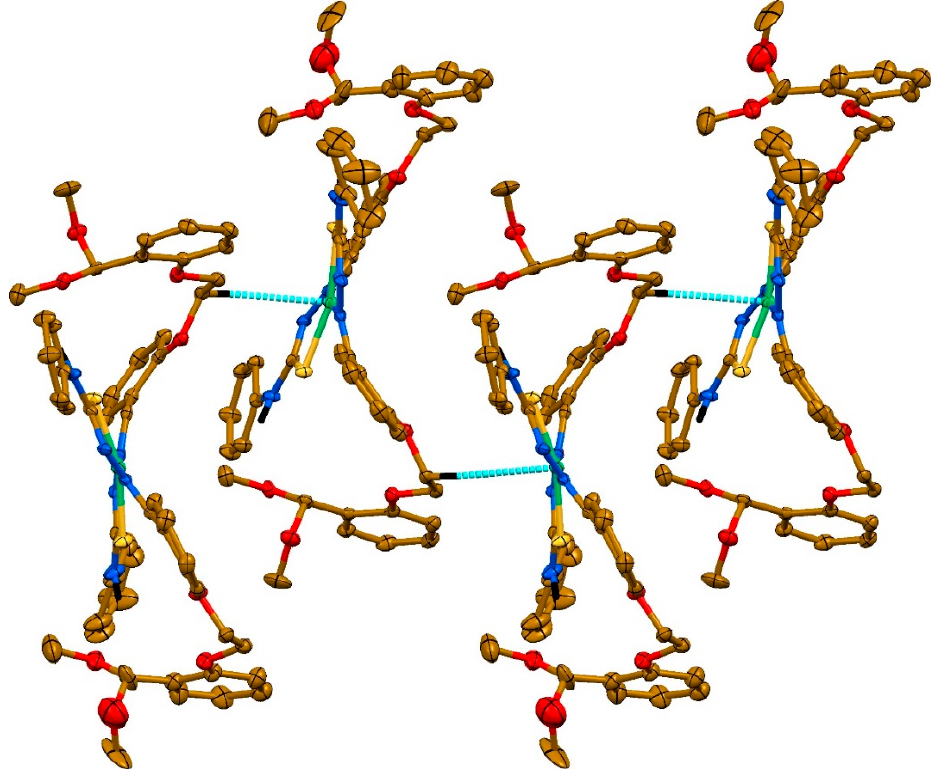
Figure 6. 1D polymeric chain, formed along the b axis by the C–H ∙∙∙ Ni anagostic bonds in the crystal structure of 2 (ellipsoids are drawn with 40% probability; CH hydrogen atoms, not involved in the anagostic interaction, are omitted for clarity). Color code: C = gold, H = black, N = blue, O = red, S = yellow, Ni = green; C–H ∙∙∙ Ni anagostic interaction = cyan dashed line.